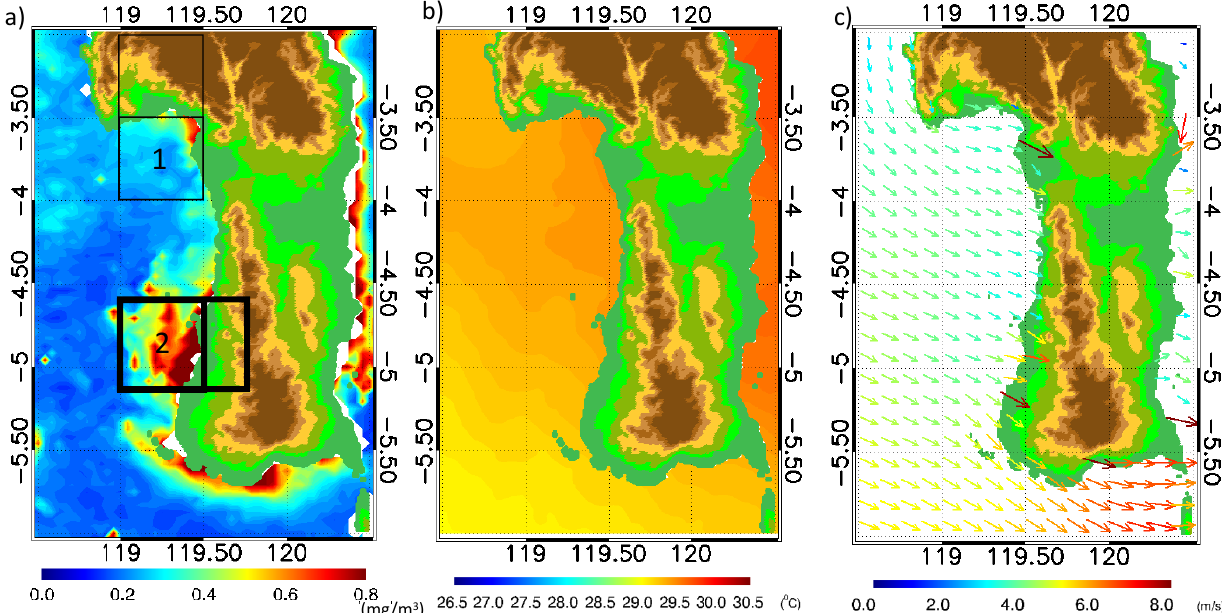
Figure 3. Spatial distribution of ( a ) Chl-a, ( b ) SST, and ( c ) surface wind along the western coast of South Sulawesi in January climatology (2007–2019). The boxes denote the sampling area for temporal analysis shown in Figure 4. Thin box represents the high Chl-a area in the northern part of the western coast of South Sulawesi and becomes the first focused area of analysis, while the thick box is for the southern part and becomes a second focused area of analysis. The averaged areas for precipitation in the boxes are extended to the land to investigate the river runoff influence on the variability of Chl-a along the western coast of the South Sulawesi.